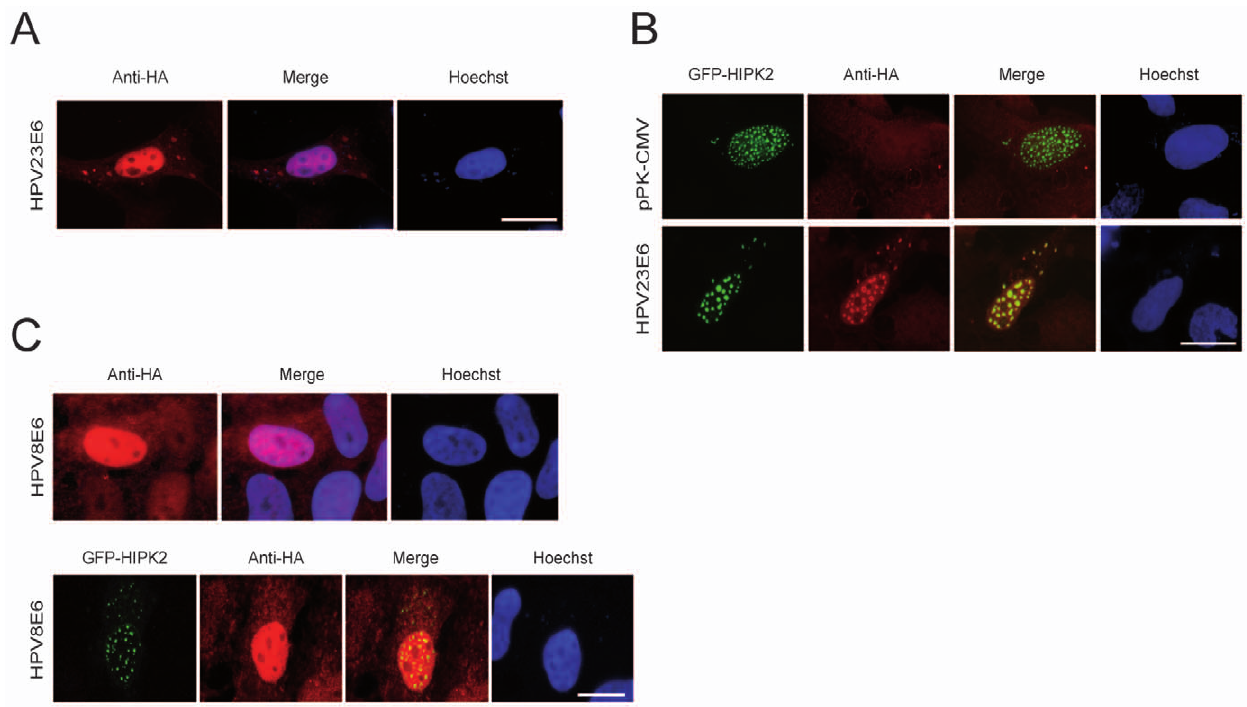
Figure 2. HIPK2 co-localize with HPV23 E6 protein in nuclear bodies. U2OS cells were transfected with HA-tagged HPV E6 either alone or in combination with GFP-HIPK2 and examined by immunofluorescence microscopy. Nuclear DNA (blue) was stained with Hoechst dye. Scale bars represent 10 m m. ( A ) Note diffuse expression patterns of HPV23 E6 proteins and ( B ) nuclear re-localization of E6 and co-localization (yellow) of GFP- HIPK2 (green) and E6 proteins (red) in nuclear bodies. ( C ) No re-localization of HPV8 E6 after overexpression of HIPK2 was observed and HIPK2 (green) do not co-localize with HPV8 E6 protein (red) demonstrated by the diffuse pattern of E6 expression. doi:10.1371/journal.pone.0027655.g002 suggesting that HPV23 E6 accumulation is not mediated by direct damage suggesting that HPV23 E6 is co-accumulated by a phosphorylation by HIPK2 (Fig. S2). Taken together, these results HIPK2-mediated feed-forward loop in order to facilitate an indicate that HPV23 E6 accumulates along with HIPK2 after UV- efficient negative control of the apoptotic function of HIPK2.